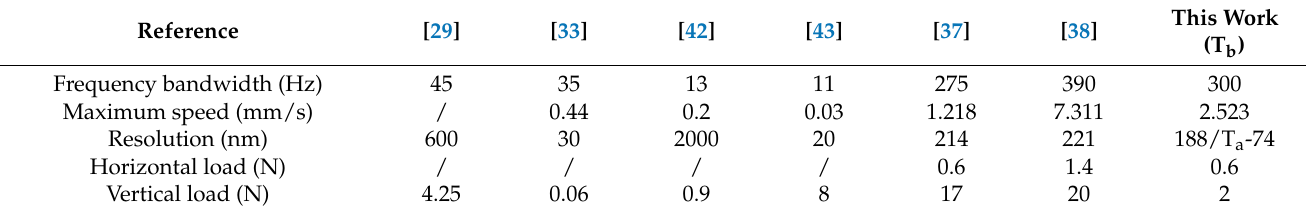
Table 2. Comparison of output characteristics between actuators reported in previous studies and the present